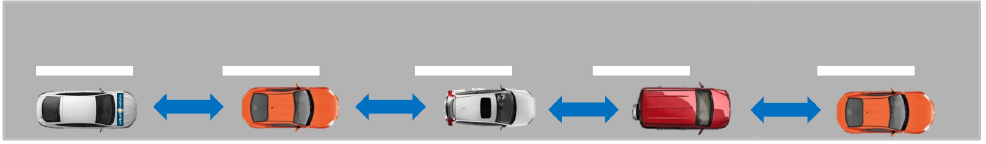
Figure 10. M86 Test Scenario 2 with the ego-vehicle in the rear position.